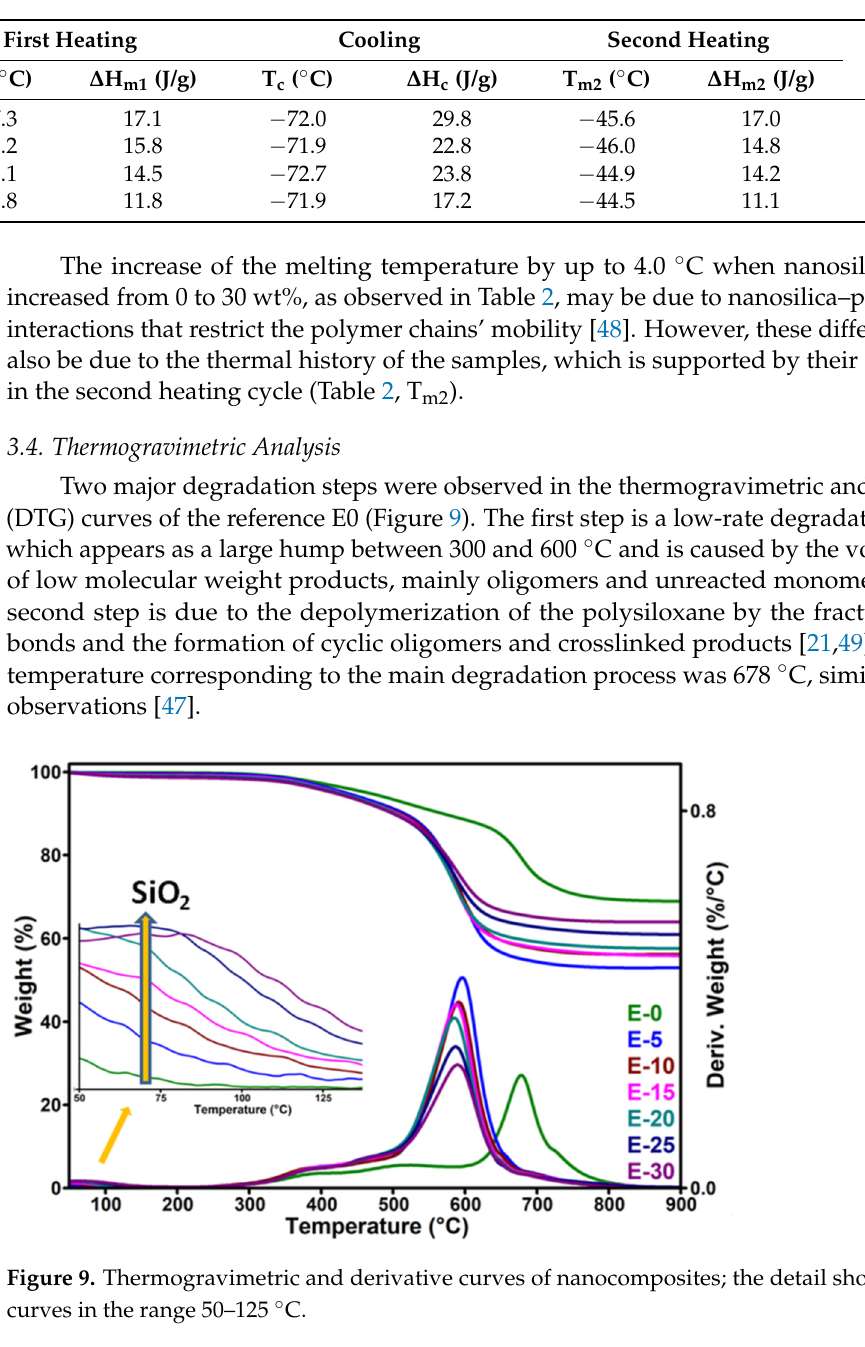
Table 2. DSC data for the nanocomposites.